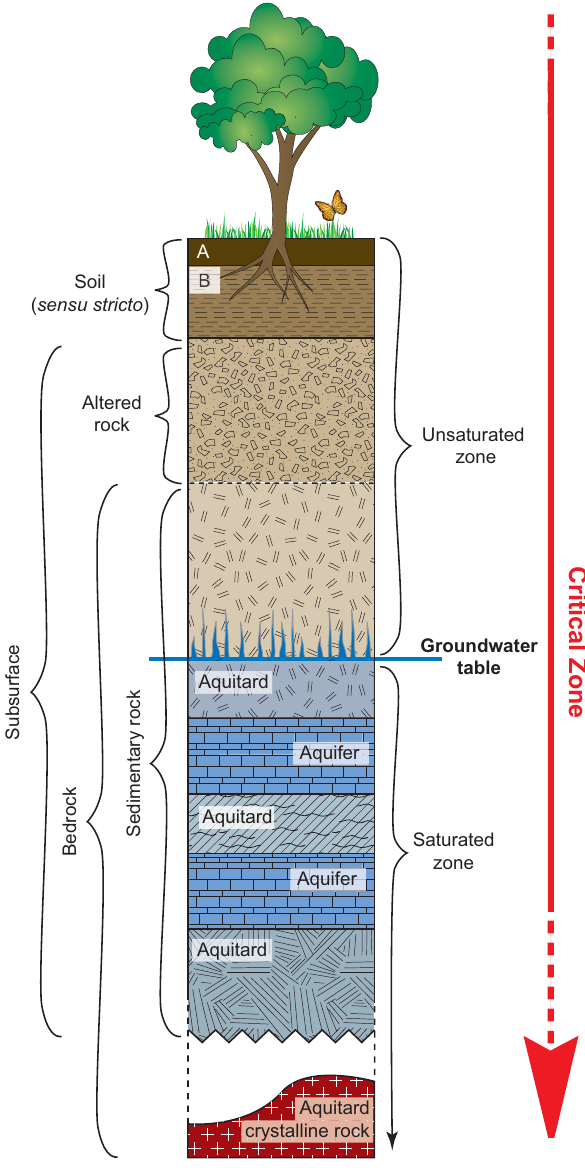
Fig. 1. The Earth’s Critical Zone as exemplified for a sedimentary rock. The portion of the biosphere ranging from the outer extent of vegetation down through the lower limits of groundwater, including the soil, altered rock, the unsaturated zone, and the saturated zone (modified from Lin, 2010). A refers to the topsoil and B refers to the